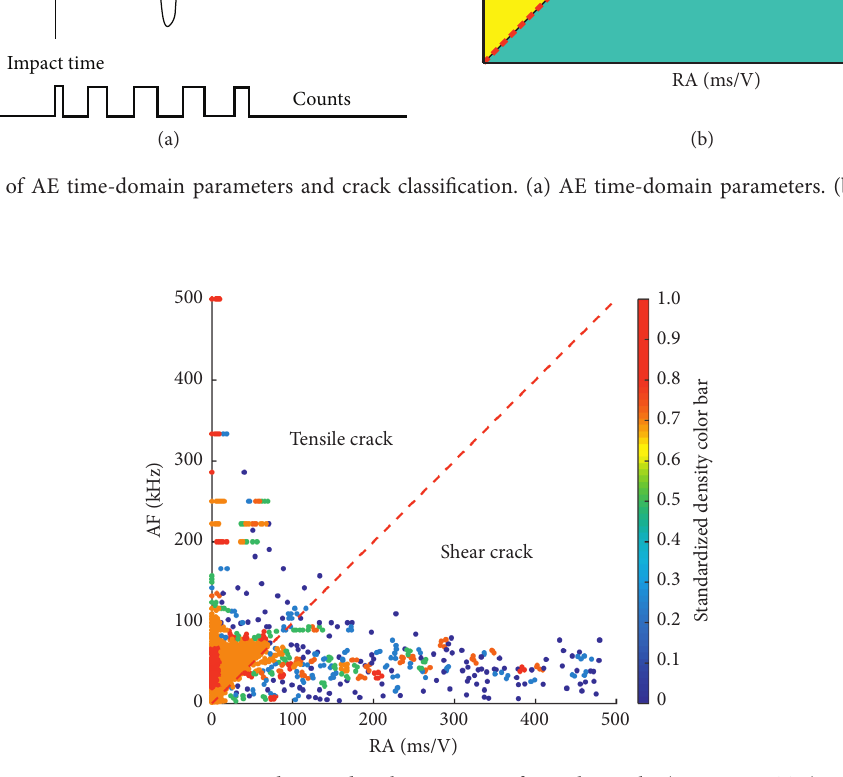
Figure 4: RA-AF scatter density distribution map of Brazilian split (specimen